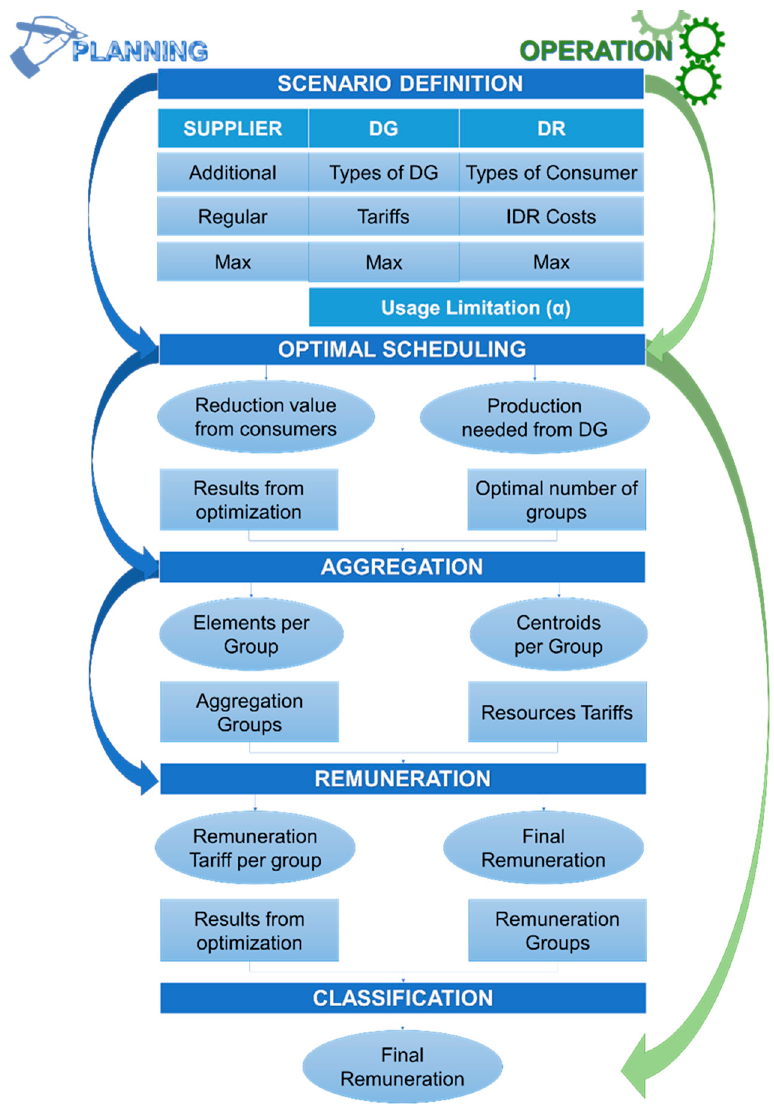
Figure 1. Diagram of the proposed methodology. DR, demand response; DG, distributed generation; IDR, incentive-based DR.